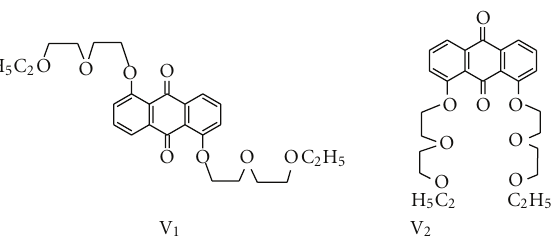
Figure 1: Used ionophores in the present